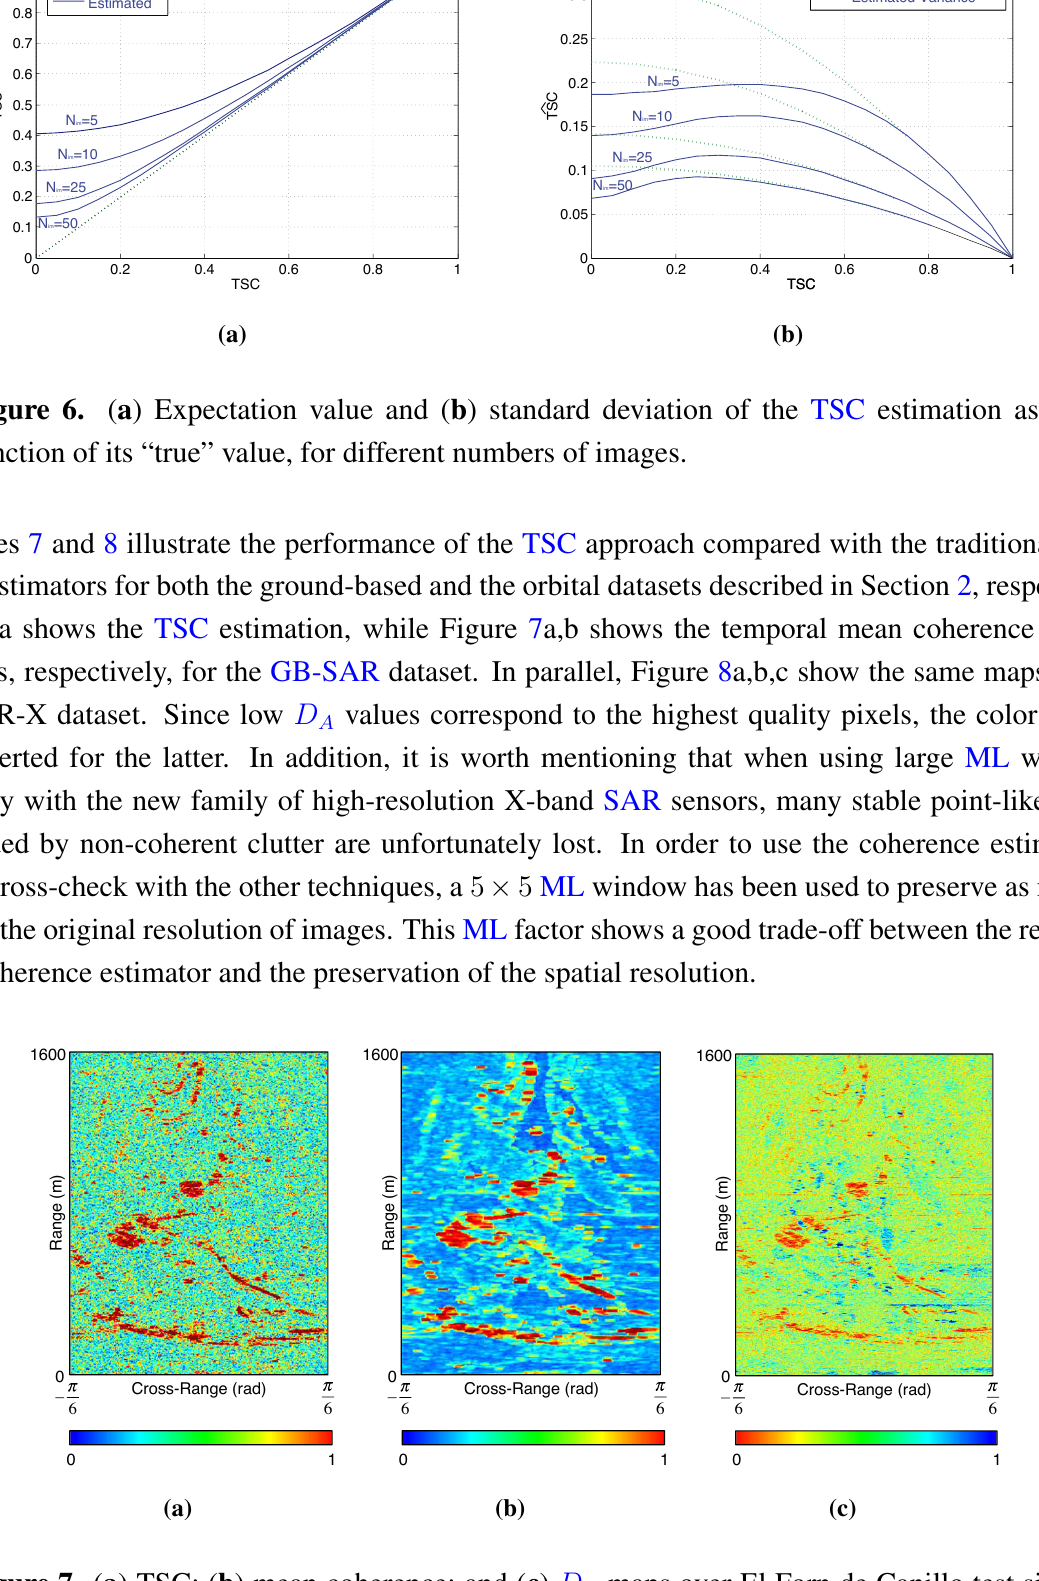
maps over El Forn de Canillo test site A